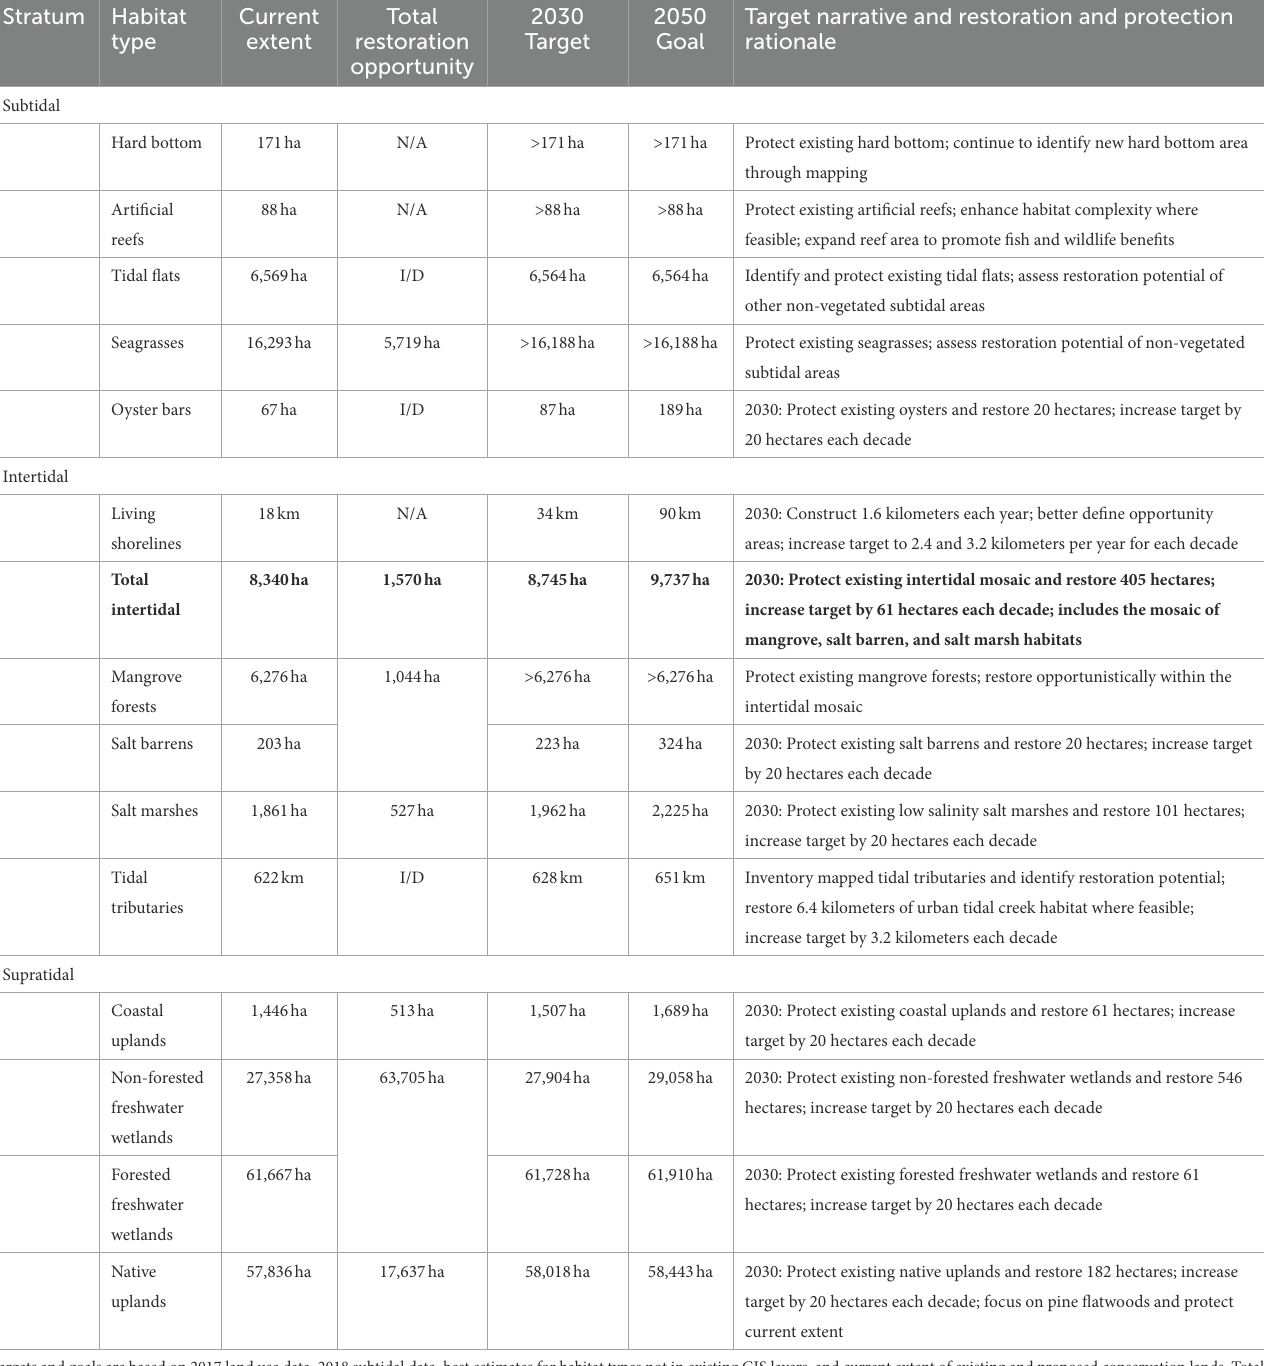
TABLE 5 Recommended 2030 targets and 2050 goals for habitat restoration and protection in the Tampa Bay watershed.